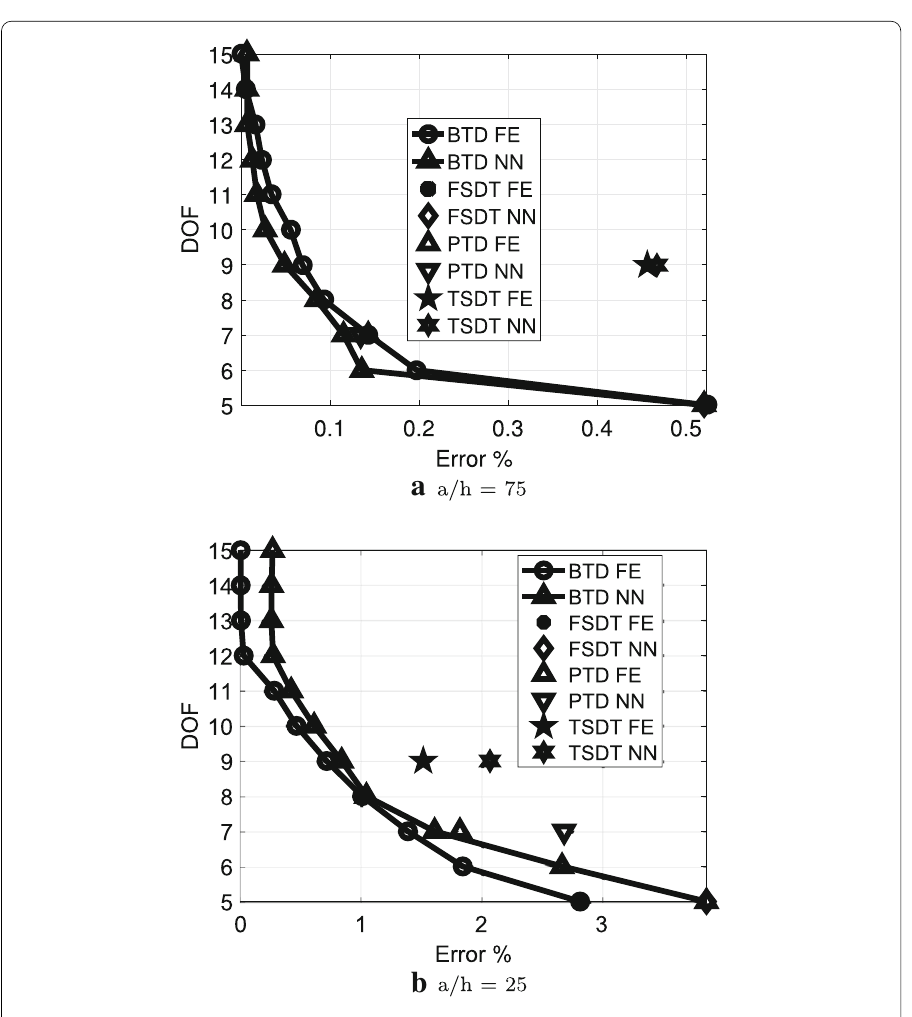
Fig. 18 FE and NN results for 0/90/0/90, a/h = 25 and 75, three layers with ten